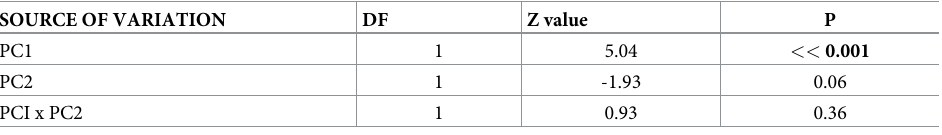
Table 1. General linear mixed model (GLMM) with negative binomial distribution, to assess the relationship between PC1 and PC2 and pine seedling abundance of Pinus radiata in fragmented forests, Maule Region, Central